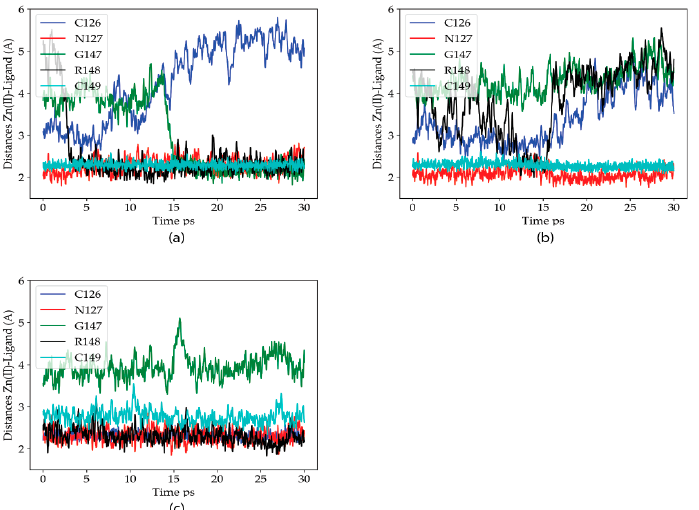
Figure 4. Zn(II) coordination distances for the identified Zn(II) ligands in the P2X4R head domain, along each of the three 30 ps QM/MM MD trajectories for the C132A/C159A mutant variants of the protein. ( a – c ) Zn(II)-Ligand distances for three different trajectories. Blue: C126, Red: N127, Green: G147, Black: R145 and Cian: C149. G147, Black: R145 and Cian: